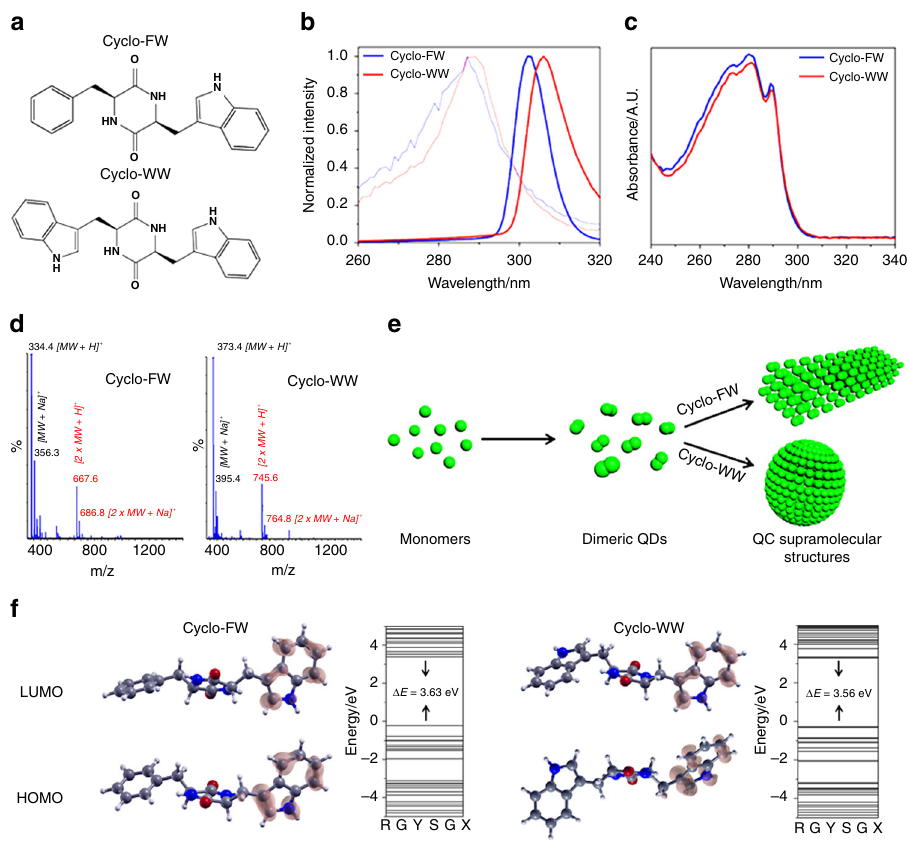
Fig. 1 Cyclo-dipeptide dimers serve as QDs to self-assemble into QC nanostructures. a Molecular structures of cyclo-FW and cyclo-WW. b Excitation spectra of cyclo-dipeptide monomers (thin light curves, 0.05 mM) and self-assemblies (thick dark curves, 5.0 mM) in MeOH. The excitation wavelengths red shifted from 285 nm to ~305 nm after self-assembly. c UV-Vis absorption spectra of the cyclo-dipeptides after self-assembly, showing spike-like absorptions at 273 nm, 280 nm, and 289 nm, characteristic of the formation of QD structures. d MS spectra of cyclo-FW and cyclo-WW at 5.0 mM in MeOH. The dimeric MW is marked in red, and the monomeric MW is marked in black. e Schematic representing the process of cyclo-dipeptides self- assembly: the monomers form dimeric QDs, which serve as the building blocks to self-assemble into larger QC architectures. f Calculated molecular orbital amplitude plots and energy levels of the highest occupied and lowest unoccupied molecular orbitals of cyclo-FW and cyclo-WW, showing band gaps of 3.63 eV and 3.56 eV,